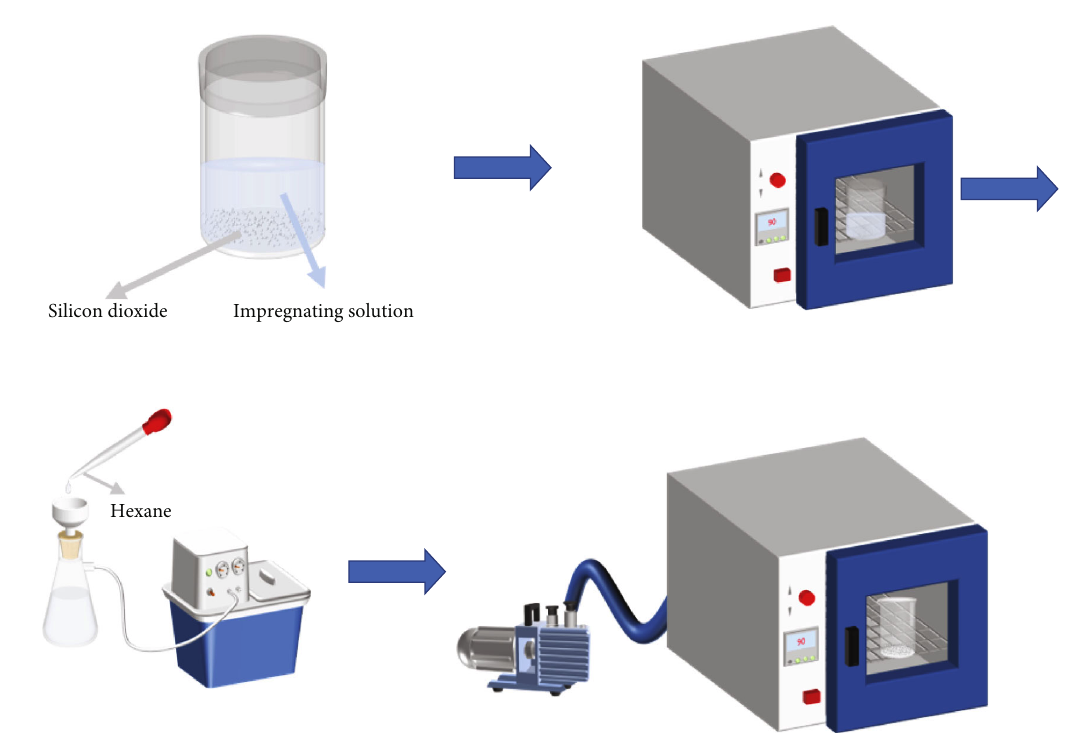
Figure 1: Schematic illustration of the process of silicon dioxide impregnation.